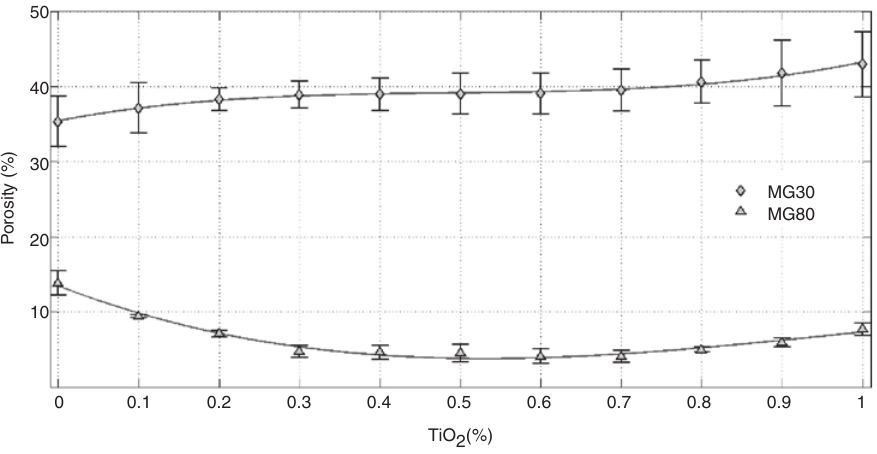
Figure 15: Porosity changes as a function of TiO